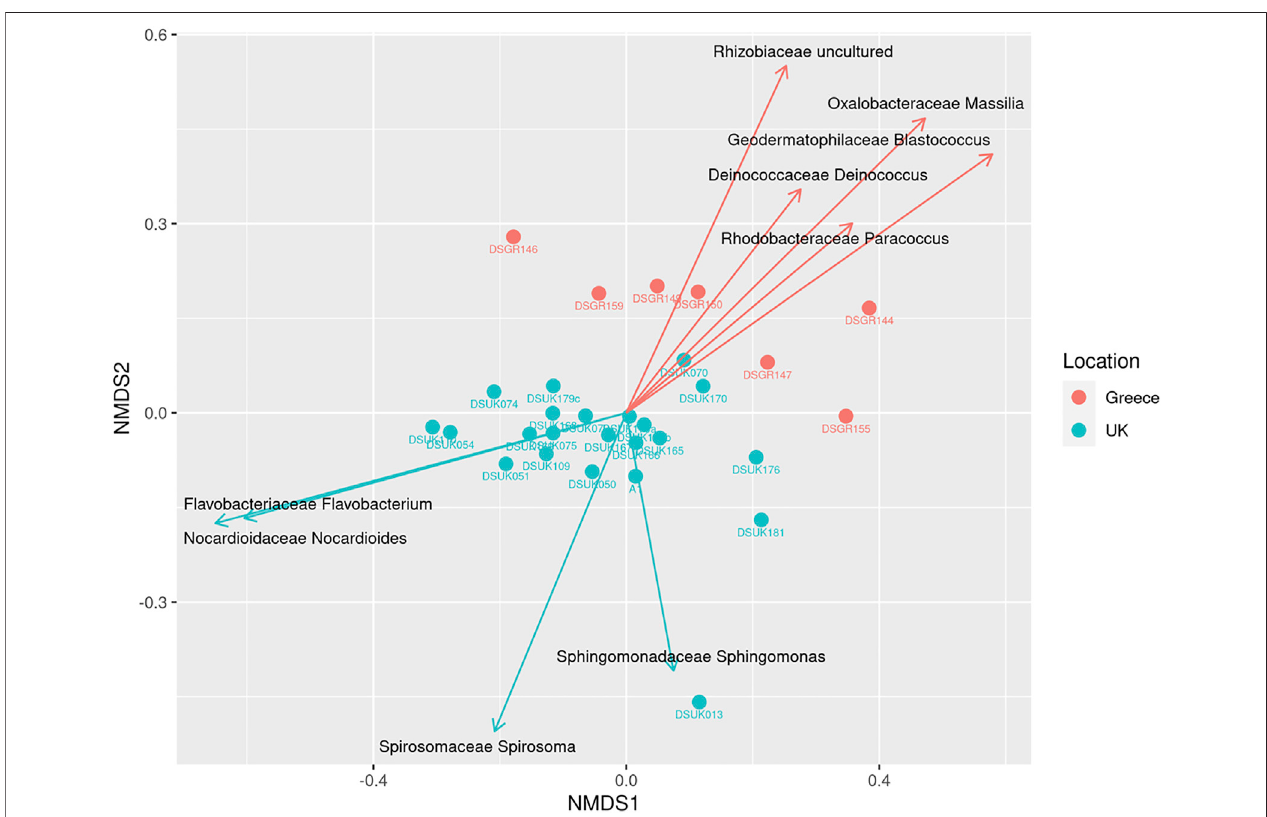
FIGURE1| BetaDiversityNMDSbi-plotusingBraydistance;vectorlinesshowFDR-adjustedstatisticallysigni fi canttaxathatcontributetoordination.Samplesare grouped by location.